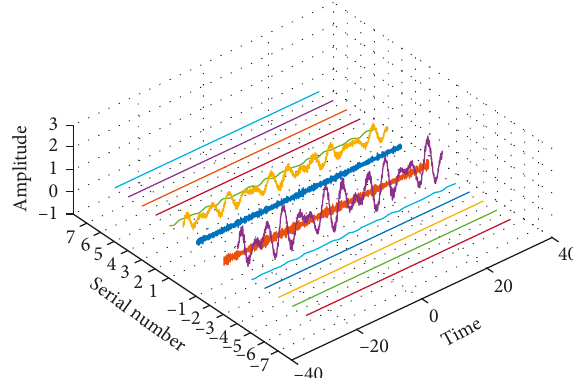
Figure 15: The real part of the new filtered signals in the time domain.